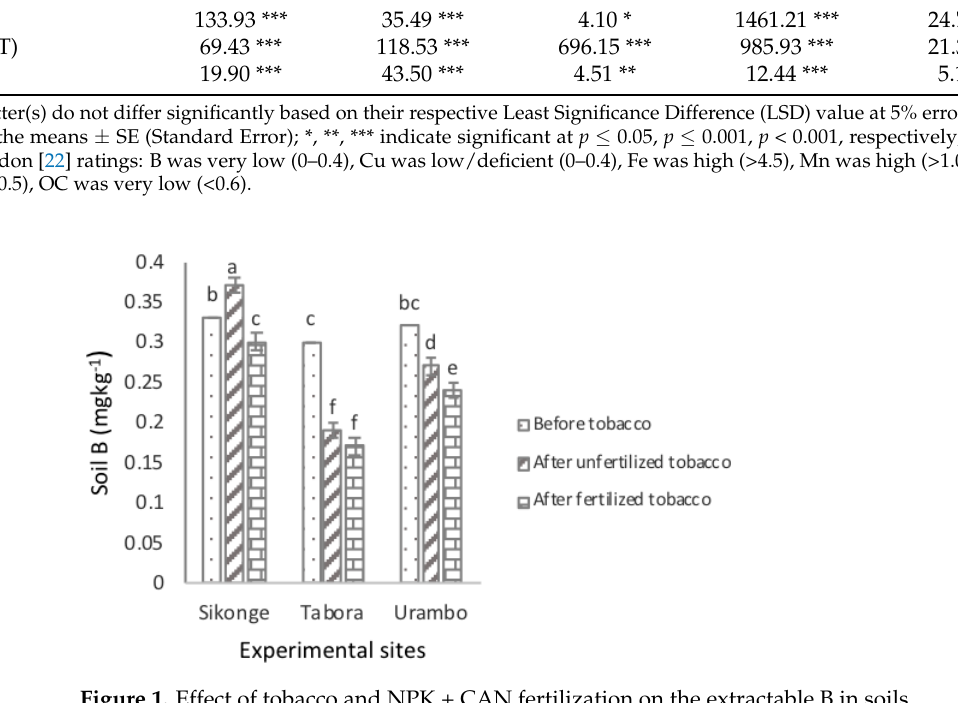
Figure 1. Effect of tobacco and NPK + CAN fertilization on the extractable B in soils. The solubility of the extractable Cu in soils was significantly ( p < 0.001) high in the Tabora (0.31 mg kg − 1 ) site followed by the Urambo and Sikonge sites with the extractable Cu of 0.29 and 0.24 mg kg − 1 , respectively. The extractable Cu increased significantly ( p < 0.001) from 0.20 mg kg − 1 before tobacco to 0.30 mg kg − 1 after the cultivation of tobacco in unfertilized soils, indicating that the tobacco increased the quantities of the extractable Cu by 0.10 mg kg − 1 . Further, the extractable Cu increased to 0.34 mg kg − 1 in tobacco-cultivated soils, indicating that fertilization caused an increase of the extractable Cu in soils by 0.14 mg kg − 1 . In combination, the effects of tobacco and fertilization caused the extractable Cu in soils to increase by 0.24 mg kg − 1 . The interactions of sites and fertilization were significant in the amounts of the extractable Cu in soils (Figure 2). Unlike the Sikonge site, the extractable Cu in the Tabora and Urambo sites increased significantly in unfertilized and fertilized tobacco-cultivated